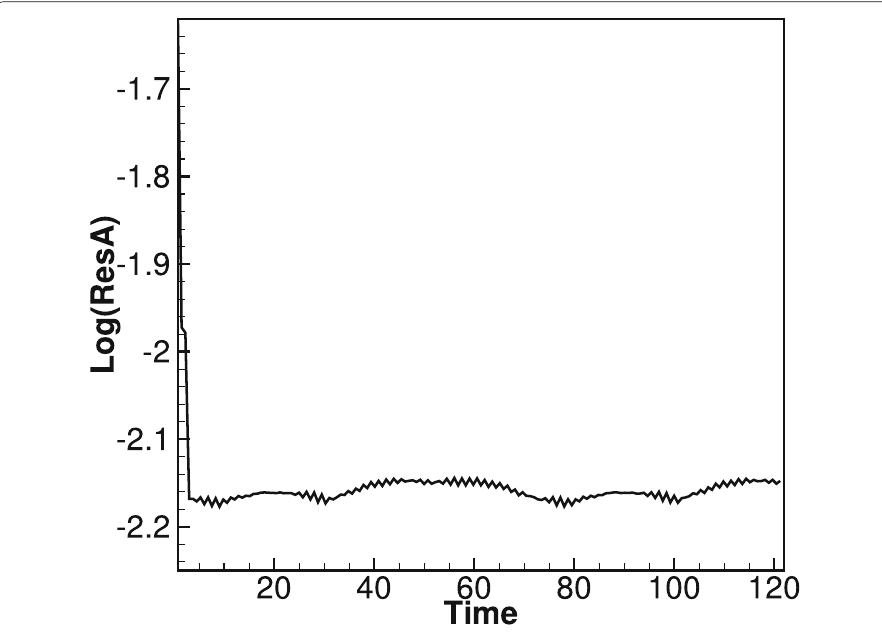
Fig. 3 The time evolution of the average residue of the 1D steady shock wave with Mach number M ∞ =